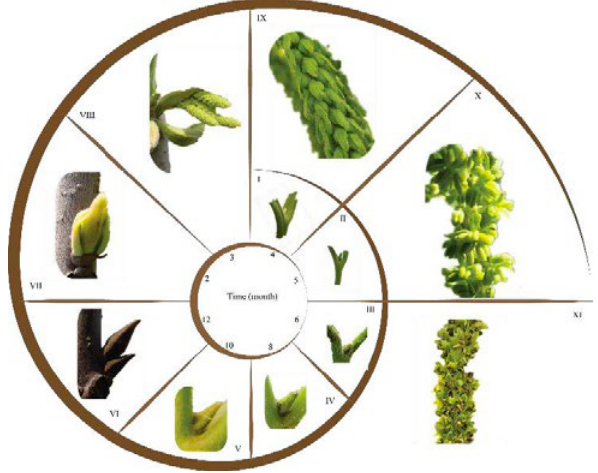
Figure 1. Cycle of pecan staminate flower differentiation over the course of one